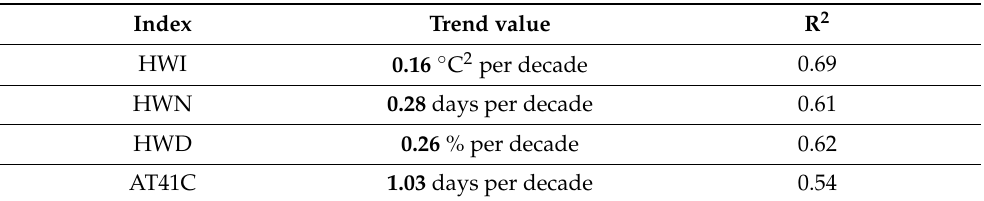
Figure 6. Spatial distribution of summer HWI trend ( ◦ C 2 per decade) calculated from ERA5-Land during the period 1950–2020. Dots indicate significant trends at the 95% level. Table 2. Trends and R 2 over Greece for the period 1950-2020. Bold values indicate significance at the 95% confidence level.